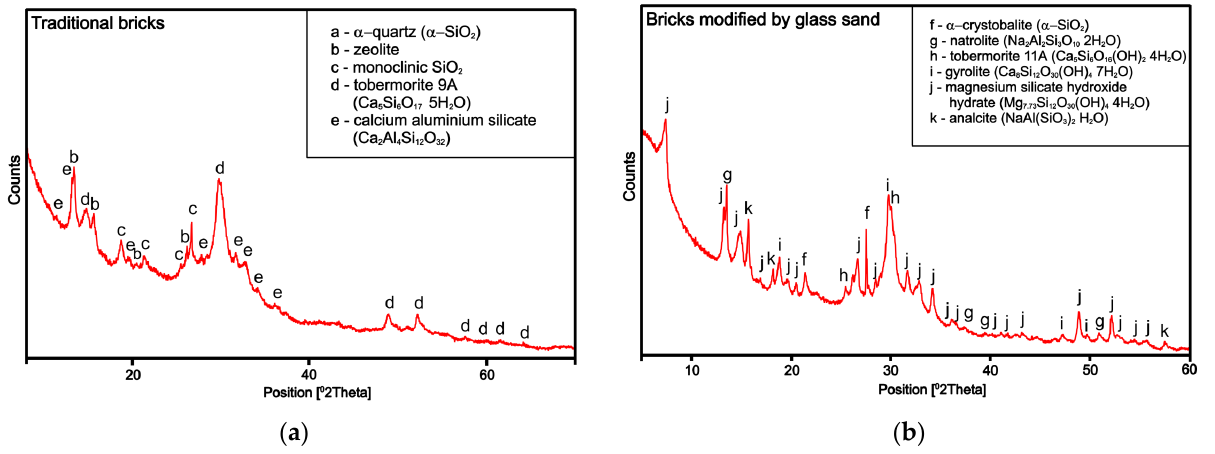
Figure 25. ( a ) XRD of reference sand-lime sample containing quartz sand (QS); ( b ) XRD analysis of the bricks modified by 90% GS after 2 months from production [38].